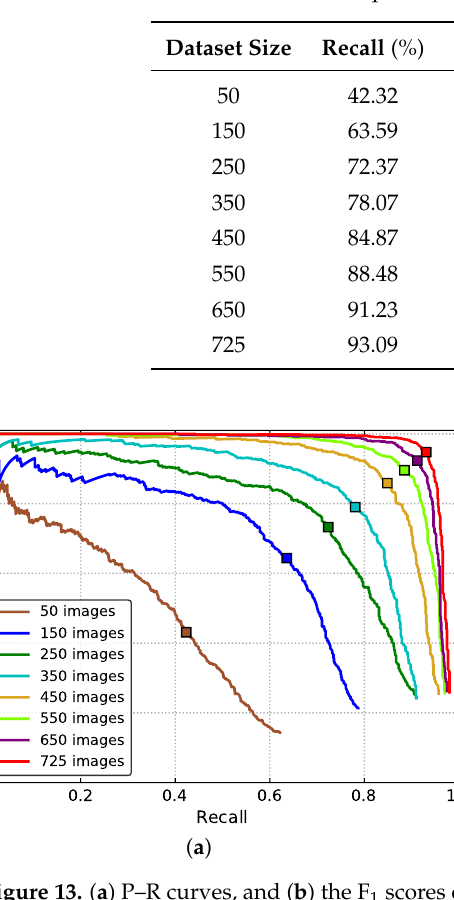
Table 2. The detection performance with different size of datasets.